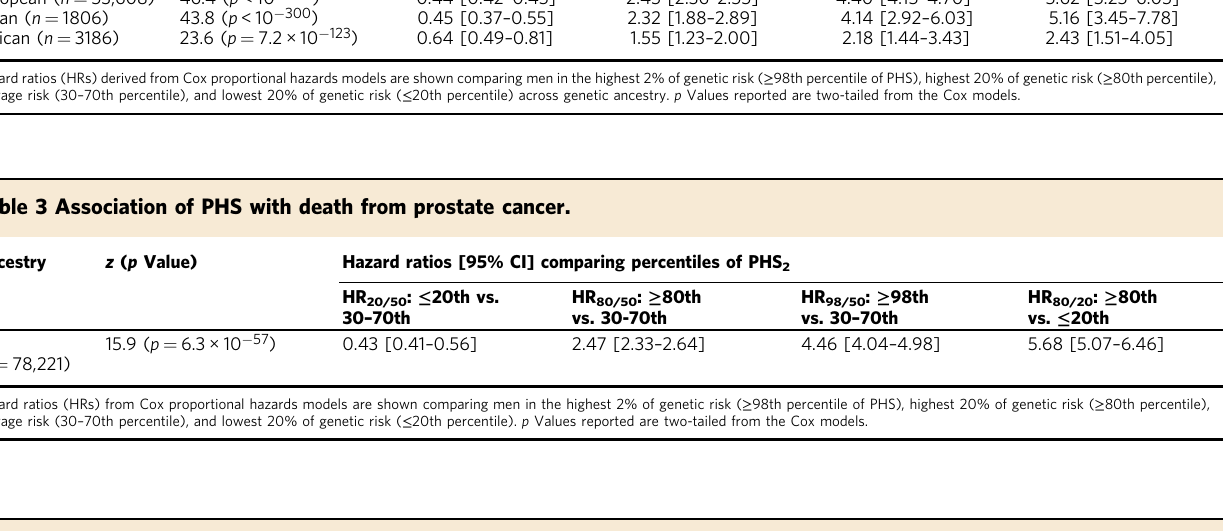
Table 4 Multivariable models with both PHS and family history of prostate cancer ( ≥ 1 fi rst-degree relative affected) for association with any prostate cancer in the multi-ethnic dataset, and by genetic ancestry. OncoArray genetic ancestry